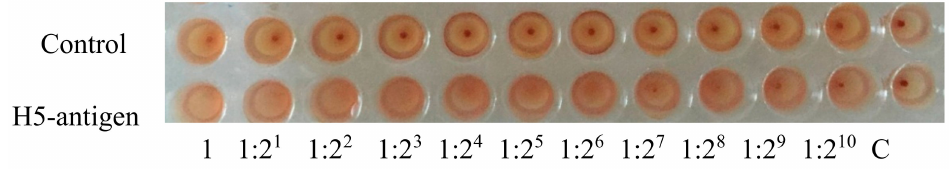
Figure 6. Assay of hemagglutinin titer for the H5N1 virus antigen. For the antigen group, the H5 antigen was added to the wells from the 1st to the 11th column. Among them, the 1st well had the original solution added, and the wells from the 2nd to the 11th column were two-fold serial diluted in turn, the final well had PBS